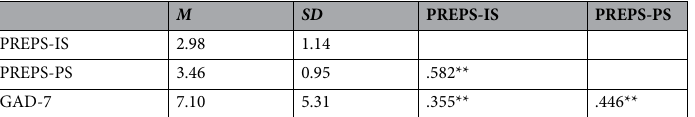
Table 3. Means, standard deviations, and intercorrelations among COVID-19 related stress and anxiety ( N = 1050) . PREPS-IS pandemic-related pregnancy infection stress, PREPS-PS pandemic-related pregnancy